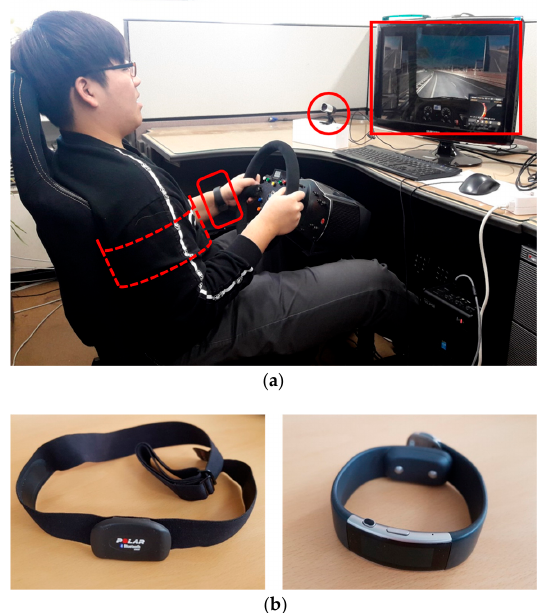
Figure 2. Data collection instruments and environment: ( a ) Driving simulation environment; ( b ) physiological devices used for heart rate variability (HRV) collection: POLAR H7 Strap ( left ) and